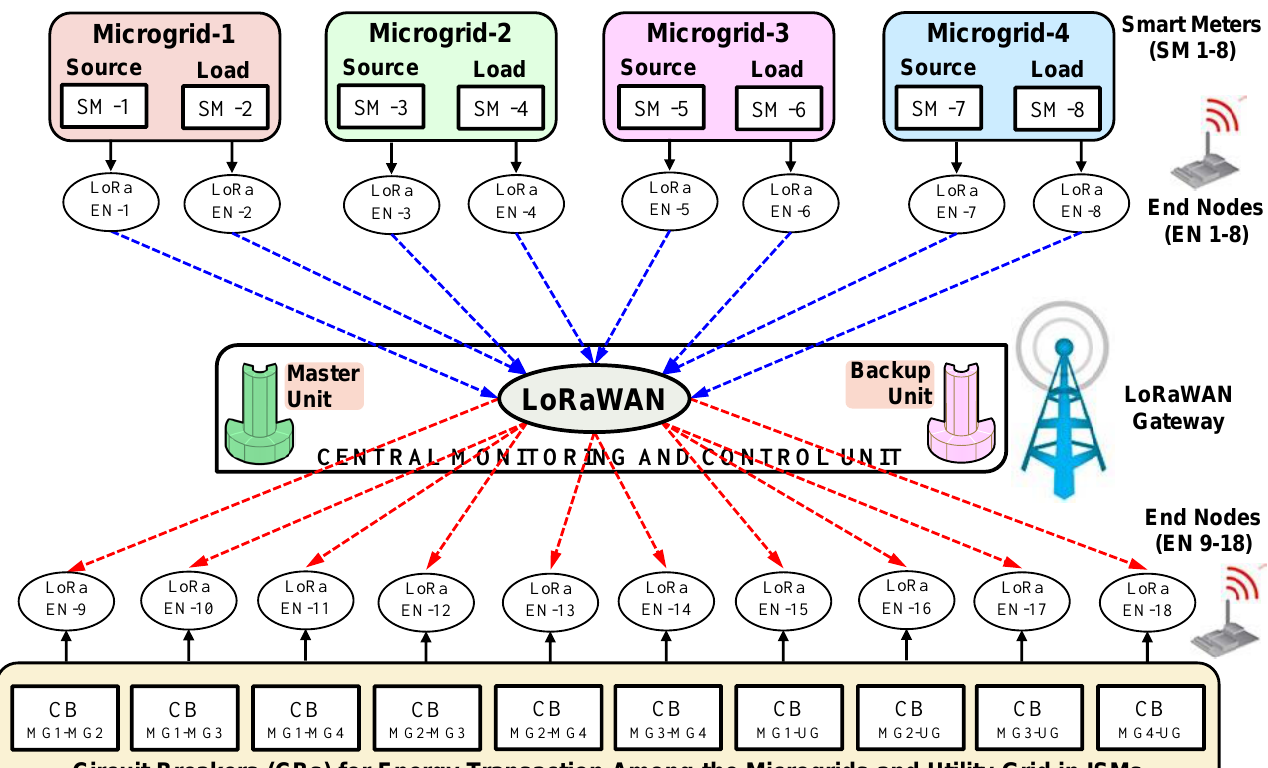
Figure 19. Low-level view of LoRa-based communication network for ISMs.